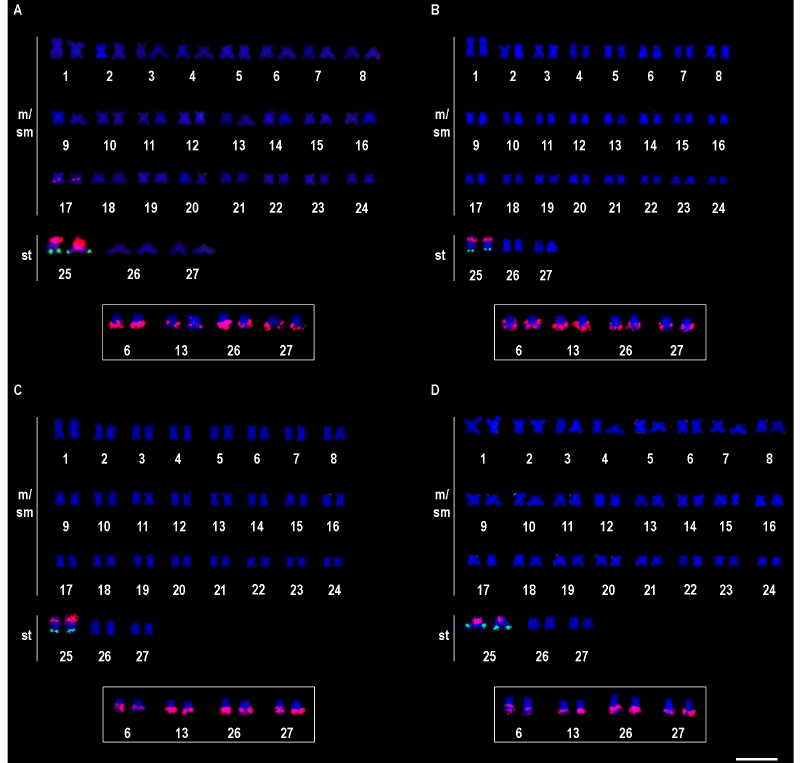
FIGURE 3 | Karyotypes of the four populations of Parodon nasus submitted to fluorescence in situ hybridization using 18S rDNA (green signal) and 5S rDNA (red signal) probes. Chromosomes with signals for the pPh2004 probe were highlighted in boxes. A. Cuiabá River; B. Mogi-Guaçu River; C. Passa Cinco River; D. Paiol Grande stream. Scale bar =